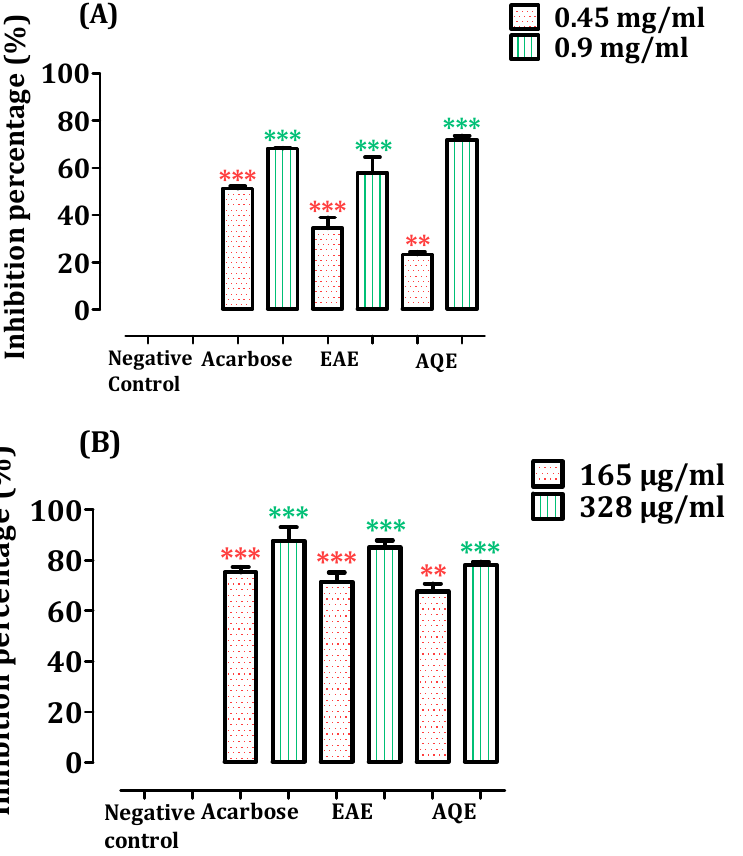
Figure 5. The effect of AQE and EAE of A. absinthium on pancreatic α -amylase enzyme ( A ), and intestinal α -glucosidase enzyme ( B ), inhibition in vitro ( n = 3). ** p < 0.01; *** p < 0.001 as compared to the control. EAE—ethyl acetate extract; AQE—aqueous extract.